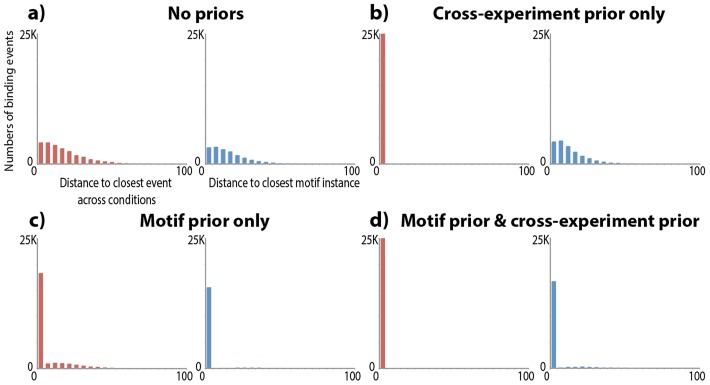
MultiGPS binding event consistency with or without the use of motif and inter-experiment priors.MultiGPS was run on two ENCODE GM12878 CTCF ChIP-seq biological replicate experiments, treating them as distinct conditions. Red histograms show the distance in base pairs from each predicted binding event in one experiment to the nearest binding event in the other condition (if within 100 bp). Blue histograms show the distance from each binding event to the nearest strong match to the CTCF motif (if within 100 bp).